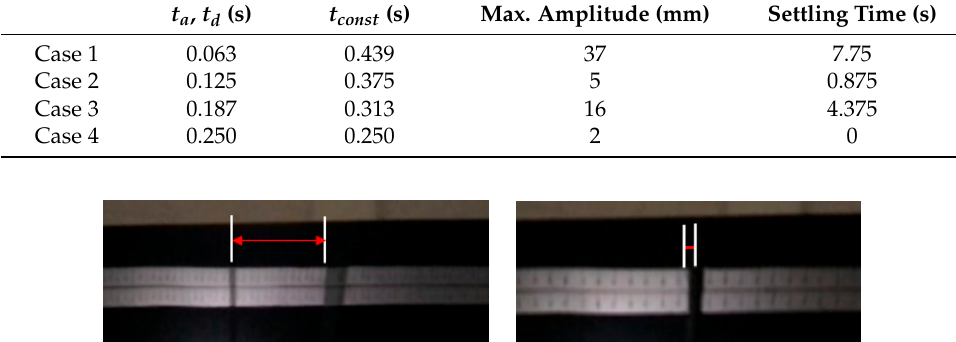
Figure 10. The velocity profiles when the robot moved 500 mm with a maximum velocity of 1000 mm/s. Table 1. Experimental results of maximum amplitude and settling time when the robot moved 500 mm with a maximum velocity of 1000 mm/s.